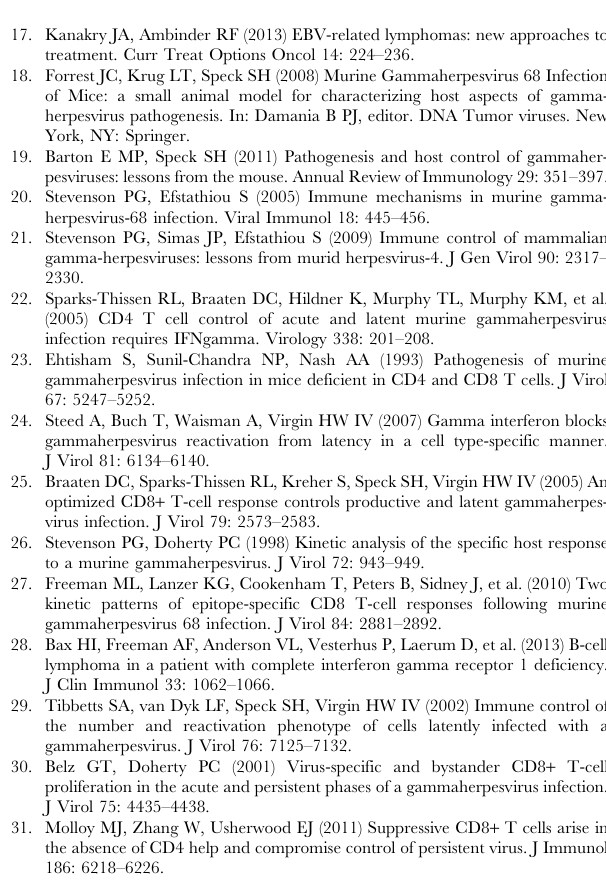
Figure S1 MHV68 replication in WT and Sts dKO cells. (A) Murine embryonic fibroblasts cells (MEFs) were infected with MHV68 at a MOI 0.05 or 5. (B) Primary bone marrow-derived macrophages were infected with MHV68 at a MOI 10. At the indicated times post infection, cultures were freeze-thawed and titered on NIH 3T12 fibroblasts. (TIF) Figure S2 Effect of Sts dKO on intraperitoneal infection and reactivation from peritoneal macrophages. Mice were infected intraperitoneally with 1000 PFU of MHV68. (A) Viral titer was measured in the spleen 9 dpi. Bar indicates median of log 10 transformed data and the dotted line marks the limit of detection. Data represents two experiments of 4–8 animals; no significant differences were found based on Mann-Whitney non-parametric t- test. (B) Splenocytes and (C) peritoneal exudate cells were harvested from ten WT mice 16 dpi and reactivation was measured by a limiting dilution ex vivo reactivation assay without T cells or with enriched T cells from Sts dKO or WT infected mice 28 dpi. The ratios of T cells to target cells are indicated in the legend. (TIF)